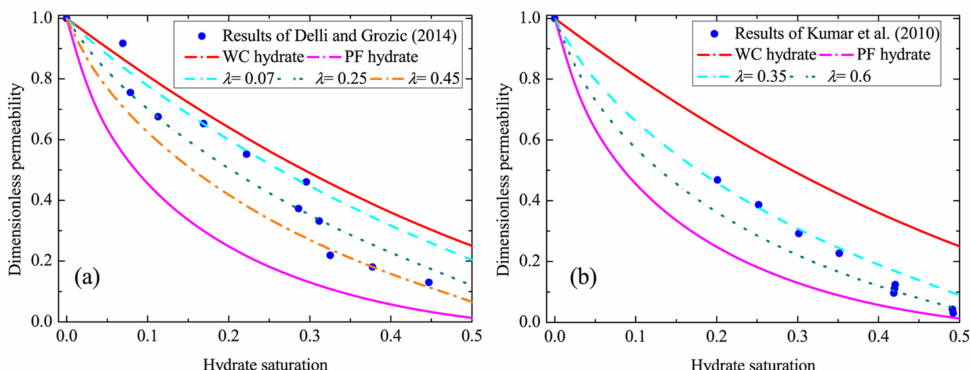
Figure 37. Dimensionless permeability varying with hydrate saturation reprinted from [71] with permission from Elsevier. (a) Experimental results of Delli and Grozic [24]; (b) experimental results from Kumar et al. [82].